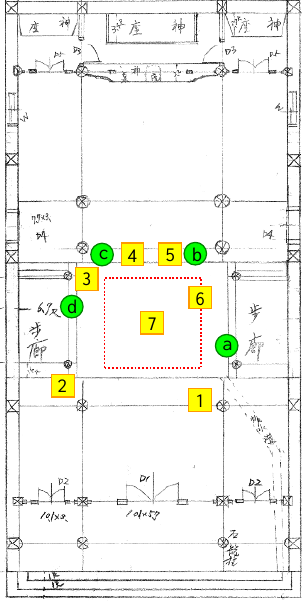
Figure 7. Global work planning of 3D laser scanning of Fu-